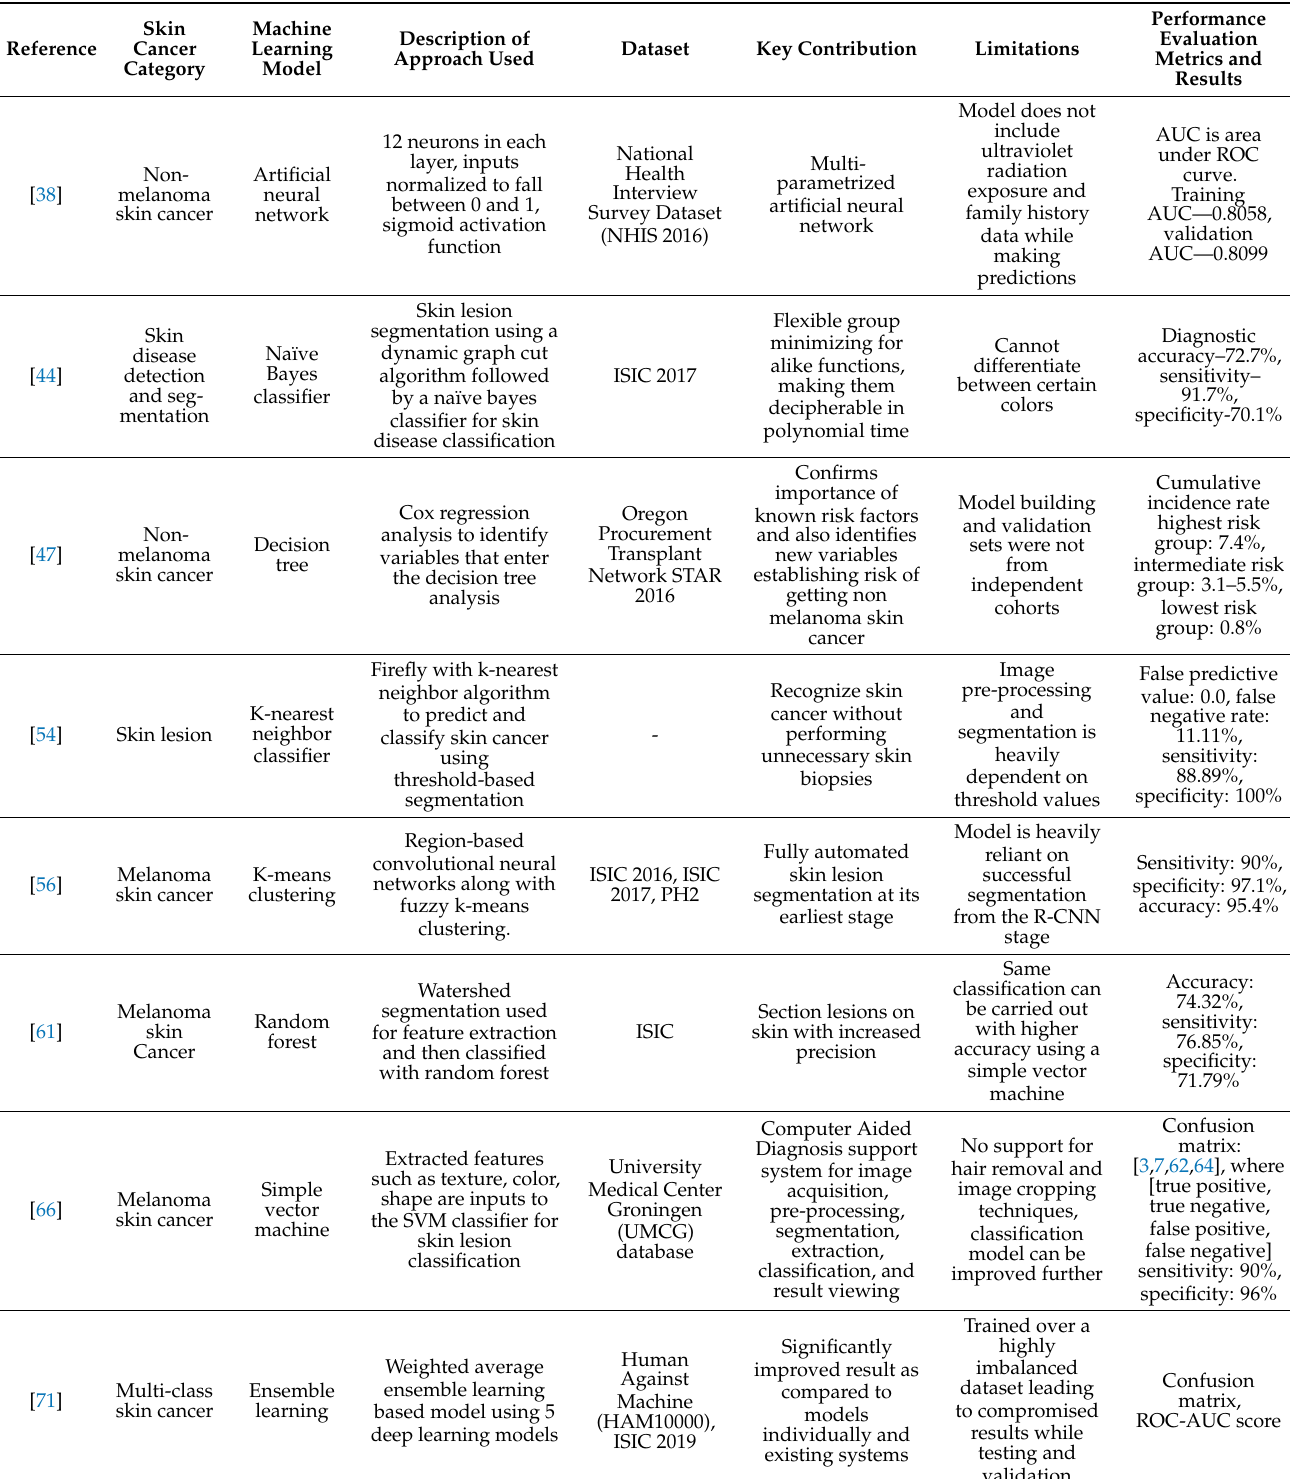
Table 4. Summary of works on machine learning techniques in skin cancer